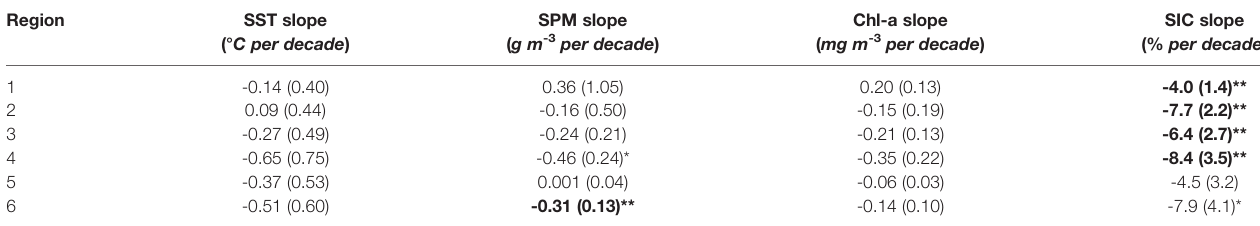
P-values less than 0.1 are indicated with one star (*) and less than 0.05 in bold with two stars (**). Standard error of the slope is indicated in